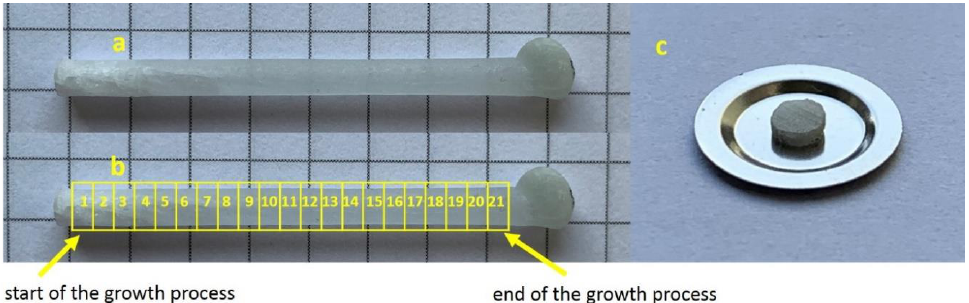
Figure 1. LMP crystal doped with Tb (0.8 mol%) ( a ), sites of sampling along the crystal axis ( b ) and a slice of the crystal placed on a Risø cup ( c